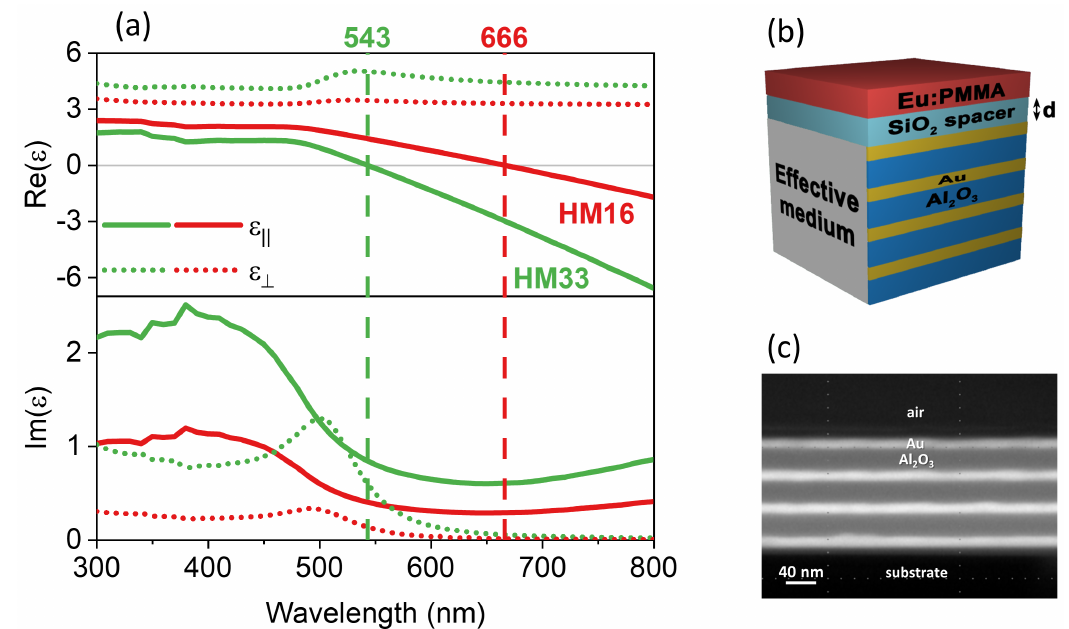
Figure 1. ( a ) In-plane ( (cid:101) (cid:107) , solid) and out-of-plane ( (cid:101) ⊥ , dotted) components of the effective permittivity (real part in the upper panel, imaginary part in the lower panel) of the produced hyperbolic meta- materials. ( b ) Sketch of the hyperbolic multilayer with SiO 2 spacer (of thickness d ) and Eu 3+ -doped PMMA film on top. ( c ) SEM image of HM33 with no